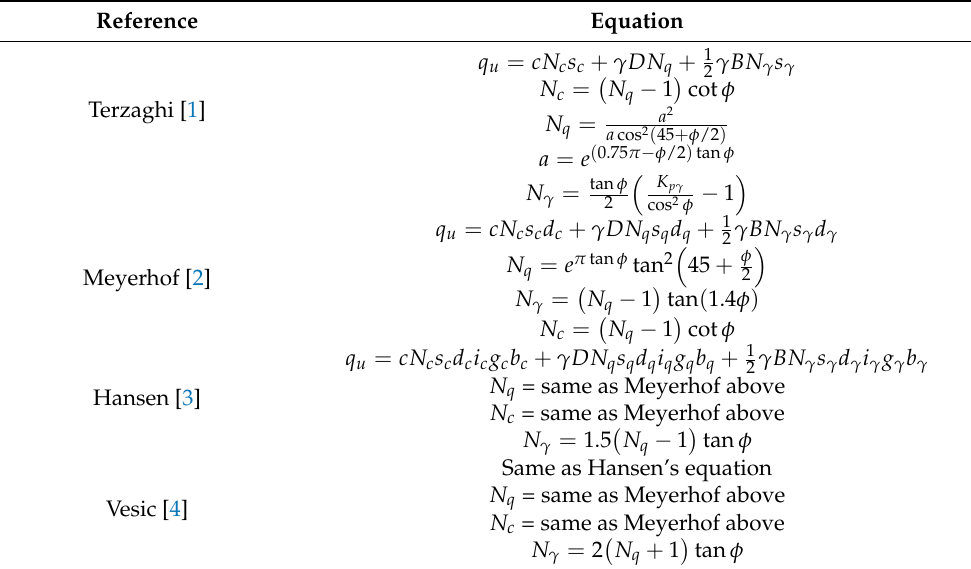
Table 1. General forms of the classical prediction equations for the bearing capacity of shallow